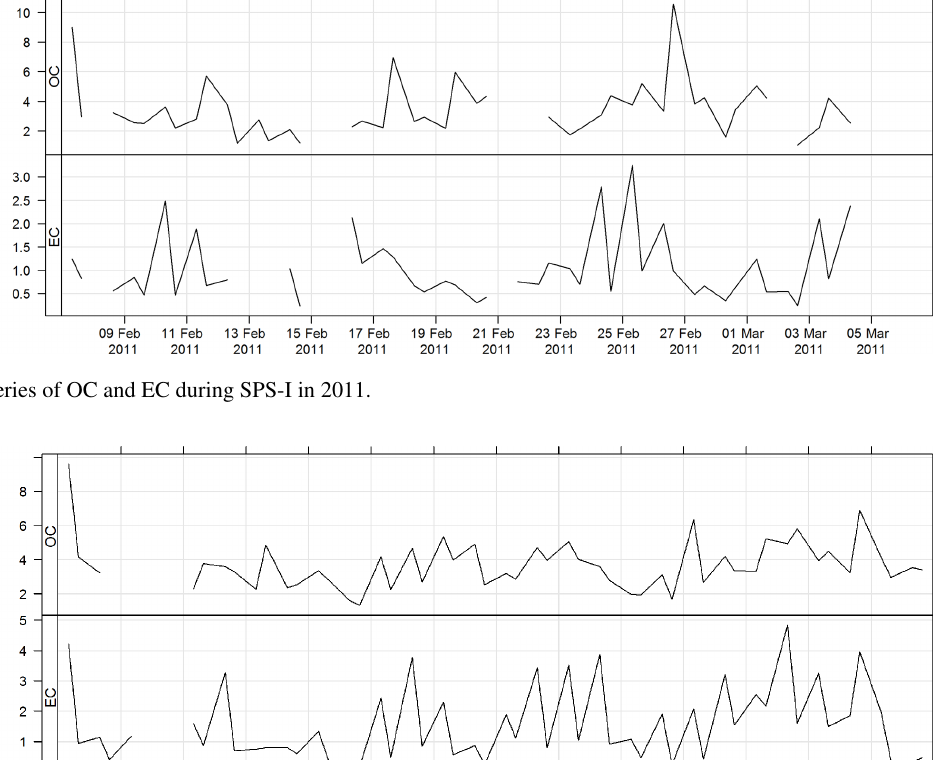
Fig. 19 and time series of methylglyoxal and formaldehyde during SPS-II are shown in Fig.